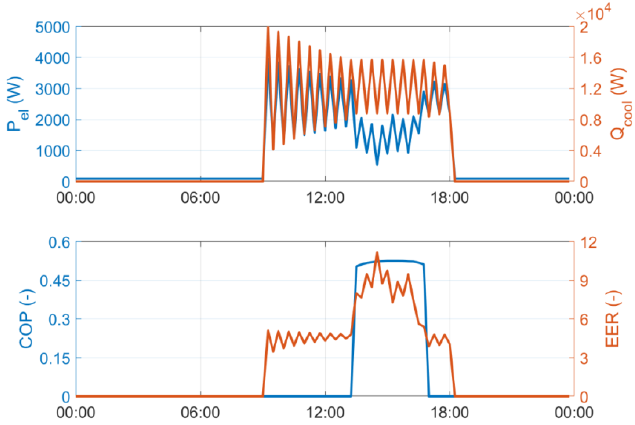
Figure 12. Overview of the cooling / electrical loads and the system’s performance for combined operation.